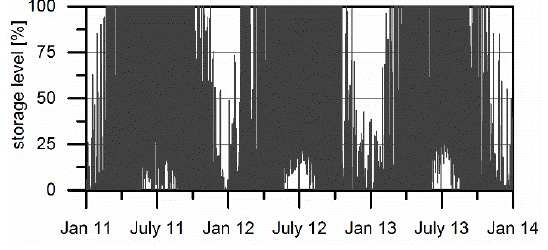
Figure 7. Storage level over the 3-year period (usable storage capacity 8 kWh).